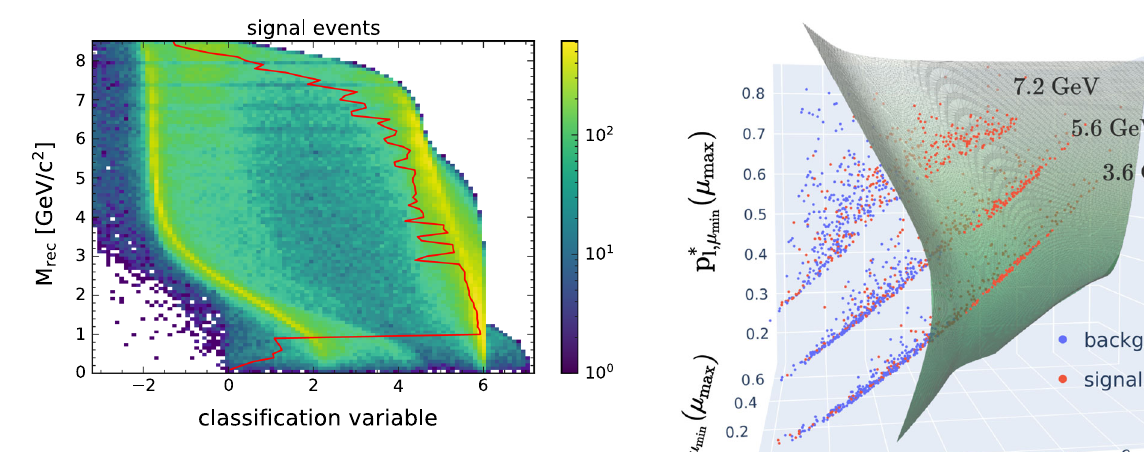
Fig. 6 The output distribution of all signal events after the BCE pre- training, overlaid with the optimal decision threshold for each signal hypothesis. The optimal cut value varies significantly across the mass spectrum